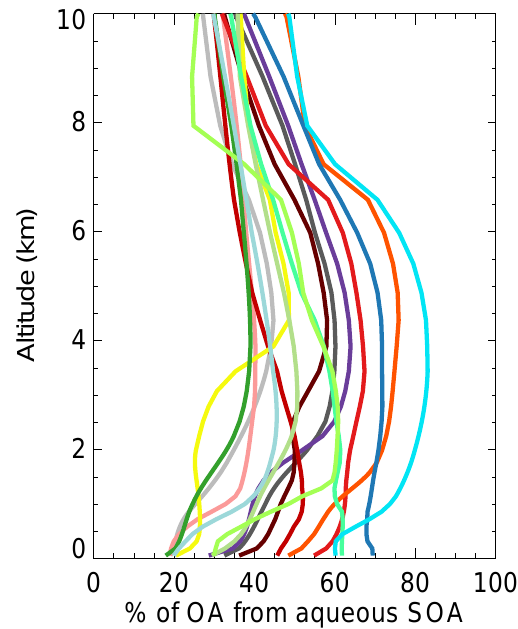
Fig. 9. Fraction of simulated OA produced from the aqueous-phase SOA mechanism of Fu et al. (2008). Monthly mean concentrations from a 2006 GEOS-Chem simulation have been sampled for the region/month of the 17 aircraft campaigns examined here (colors as in previous